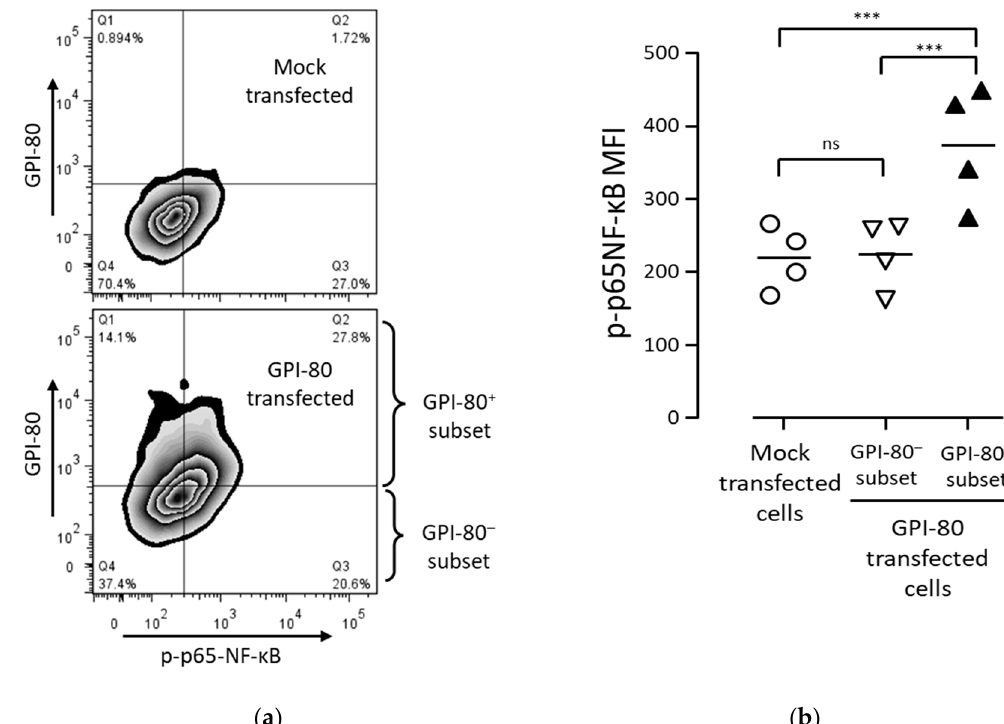
Figure 5. The relation between GPI-80-expressing cell subset and the activated NF- κ B cell subset. ( a ) The representative flow cytometric analysis of GPI-80-expressing cell subset and activated NF- κ B cell subset. PC3 cells were transfected with lentiviral vector packaged with pLV-SIN/puro-mock vector (upper panel) or pLV-SIN/puro-GPI-80 vector (lower panel), and the infected cells were incubated for 2 days. After incubation, the cells were stained with PE-conjugated anti-GPI-80 mAb (3H9) and Alexa 647-conjugated anti-phosphorylated p65-NF- κ B mAb (93H1) and analyzed by flow cytometry. The representative analysis is from four independent experiments. The horizontal axis is phosphorylated p65-NF- κ B (p-p65 NF- κ B) level, and the vertical axis is GPI-80 level on the zebra-contour panels. ( b ) The p-p65 NF- κ B MFI in mock-transfected PC3 cells. GPI-80 - cell subset and GPI-80 + cell subset were separated from GPI-80-transfected cells, as shown in ( a ). The p-p65 NF- κ B MFI was analyzed in mock-transfected cells (open circle), GPI-80- cell subset (open inversed triangle) and GPI-80+ cell subset (closed triangle). The data represent results from four independent experiments, and the statistical significance was calculated by one-way ANOVA with Bonferroni’s post-hoc test, compared with each other (***, p < 0.001; ns, not significant).